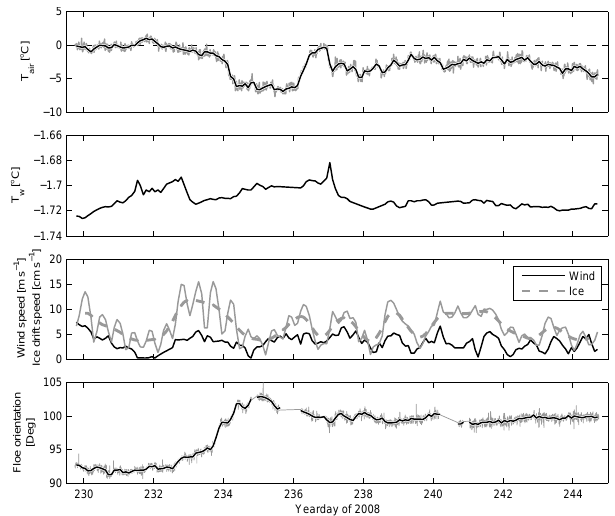
Fig. 3. Time series of (a) air temperature at 21m height, (b) wa- ter temperature at 3.8m depth, (c) wind speed (in ms − 1 ) , ice drift speed (incms − 1 ) and (d) orientation of the floe’s main axis (see location of axis in Fig.